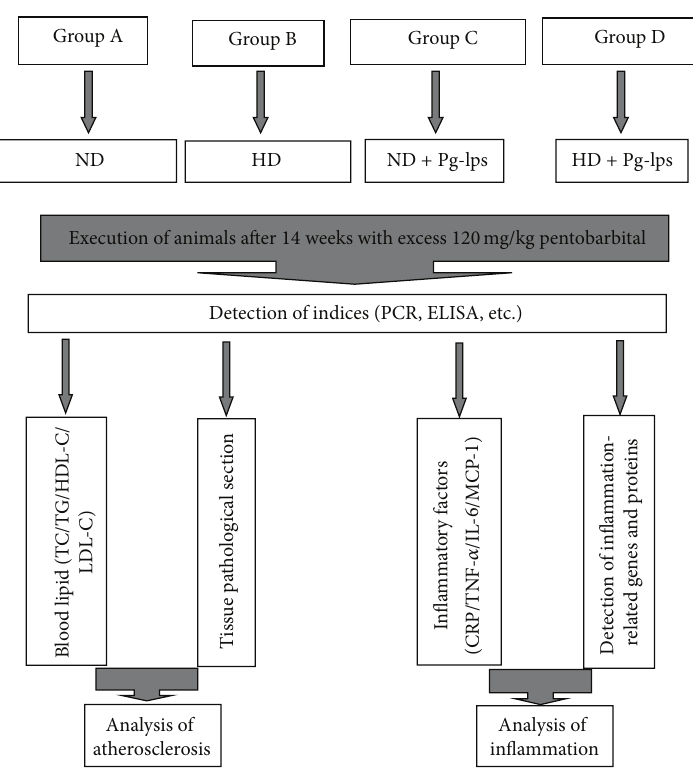
Figure 1: Experimental procedure. ND: normal diet; HD: high-fat